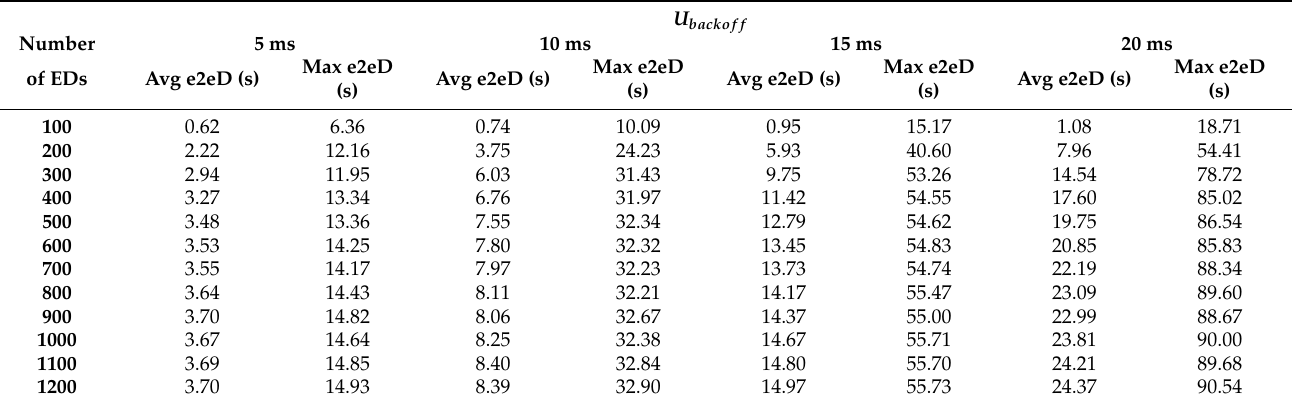
Table 12. Case C ( MAC max = 15): Average and maximum e2eD varying the number of EDs and nBackof f the U backof f